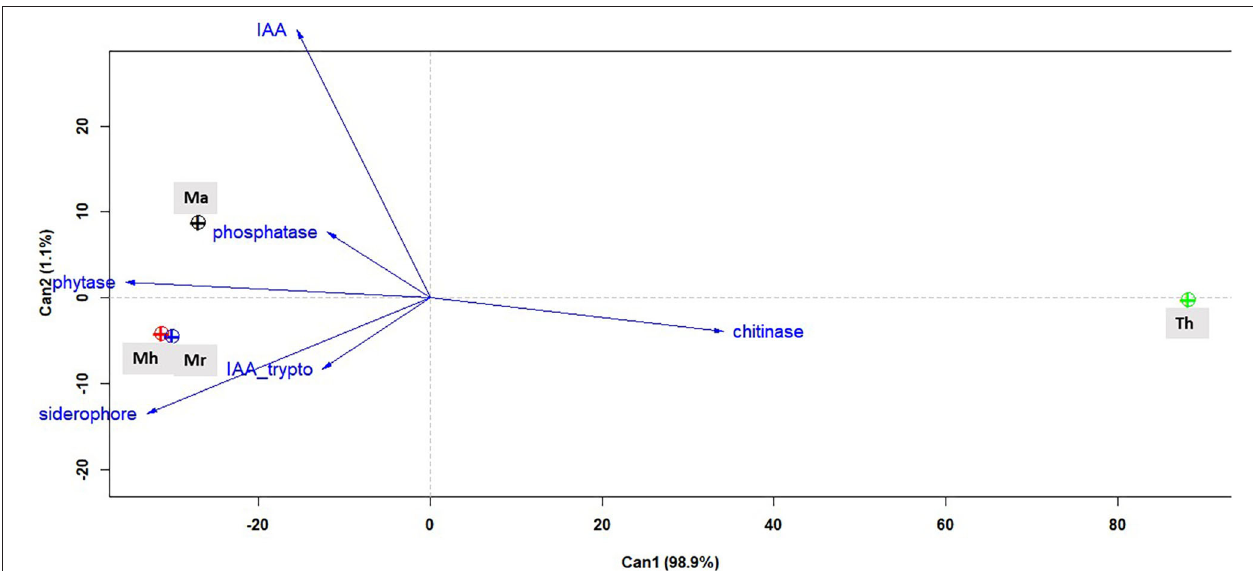
FIGURE 8 | Canonical discriminant plot (or simply biplot) showing two principal canonical components in which the blue vectors correspond to the response biochemical variables and circle groups are attributed to fungal species (Th, T. harzianum; Ma, M. anisopliae; Mr, M. robertsii; Mh, M. humberi) represented by different colors ( n = 24 observations used per fungal species). IAA_trypto, production of indole-3-acetic acid (IAA) with medium amended with L-tryptophan; IAA, IAA production with medium without the addition of exogenous L-tryptophan. Legends in the biplot: black, M. anisopliae; green, T. harzianum; red, M. humberi; and blue, M.